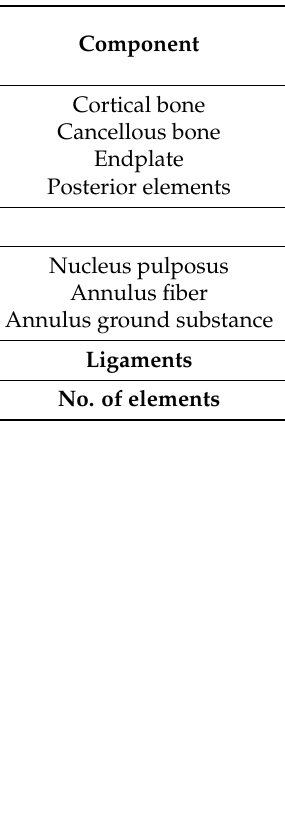
Table 2. Element count and mesh type of the present intact